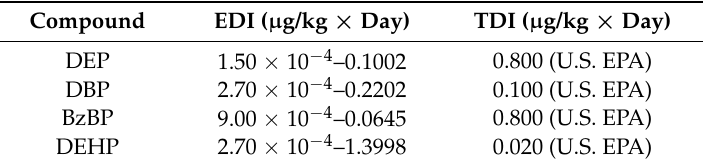
Table 9. Characteristics of the investigated phthalates.